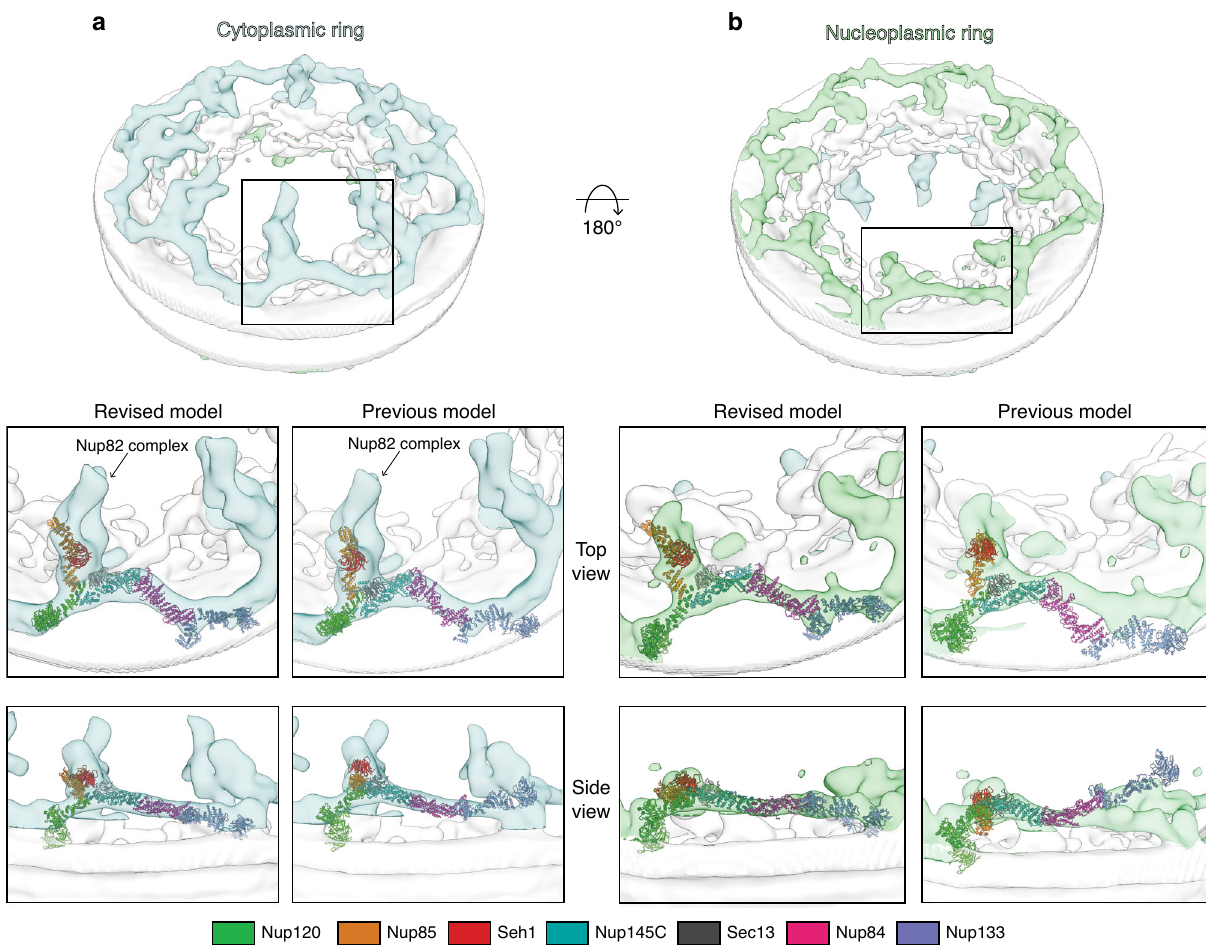
Fig. 7 Fitting of the composite S. cerevisiae Y complex into the cryo-ET map of the NPC. Cryo-ET map from S. cerevisiae (EMD-10198) with the density corresponding to the a cytoplasmic ring of the NPC colored in light blue and b the nucleoplasmic ring colored in light green. The top-scoring global fi t for both the previous (left panel) and revised (right panel) composite S. cerevisiae Y complex models shown in both a top and side view. Y complex nups colored as in legend